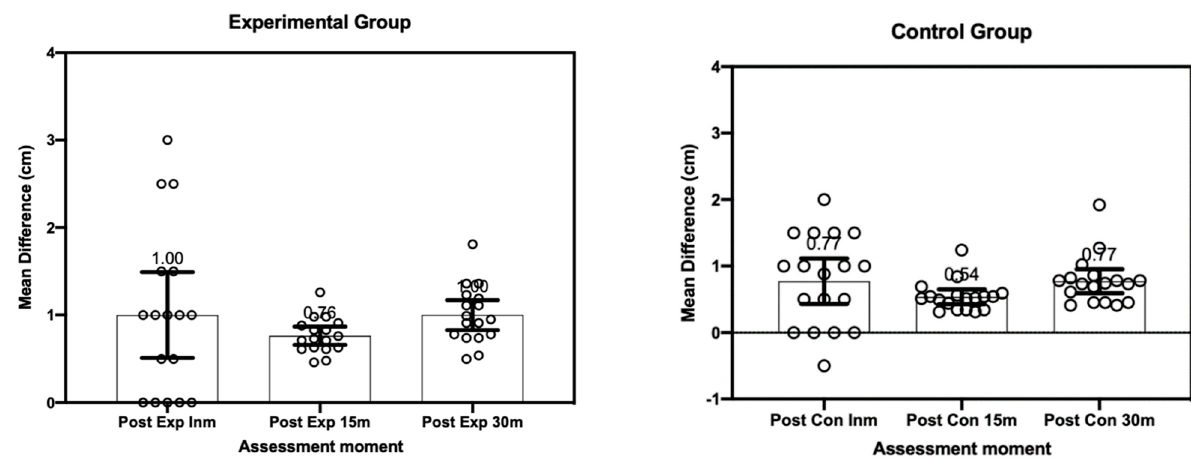
Figure 5. Differences in ankle mobility (in cm) in each of the intervention conditions. The figure shows the values of the difference between the conditions obtained by each subject (circles) both in the experimental conditions and in the control conditions. Bars represent the mean value, while boxplots represent the 95% confidence interval. The mean value of each condition is represented at the top edge of the CI. Prepared by the authors. (Exp: experimental group; Con: Control; Post INM: post immediately; P15: after 15 min intervention; PI 30: after 30 min intervention).